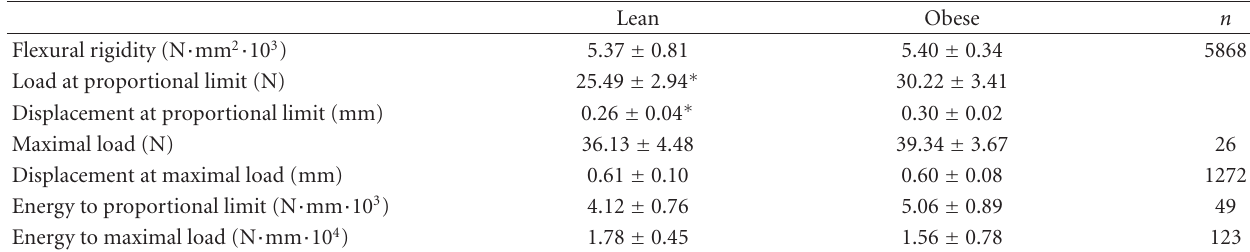
Table 2: Tibial structural properties.